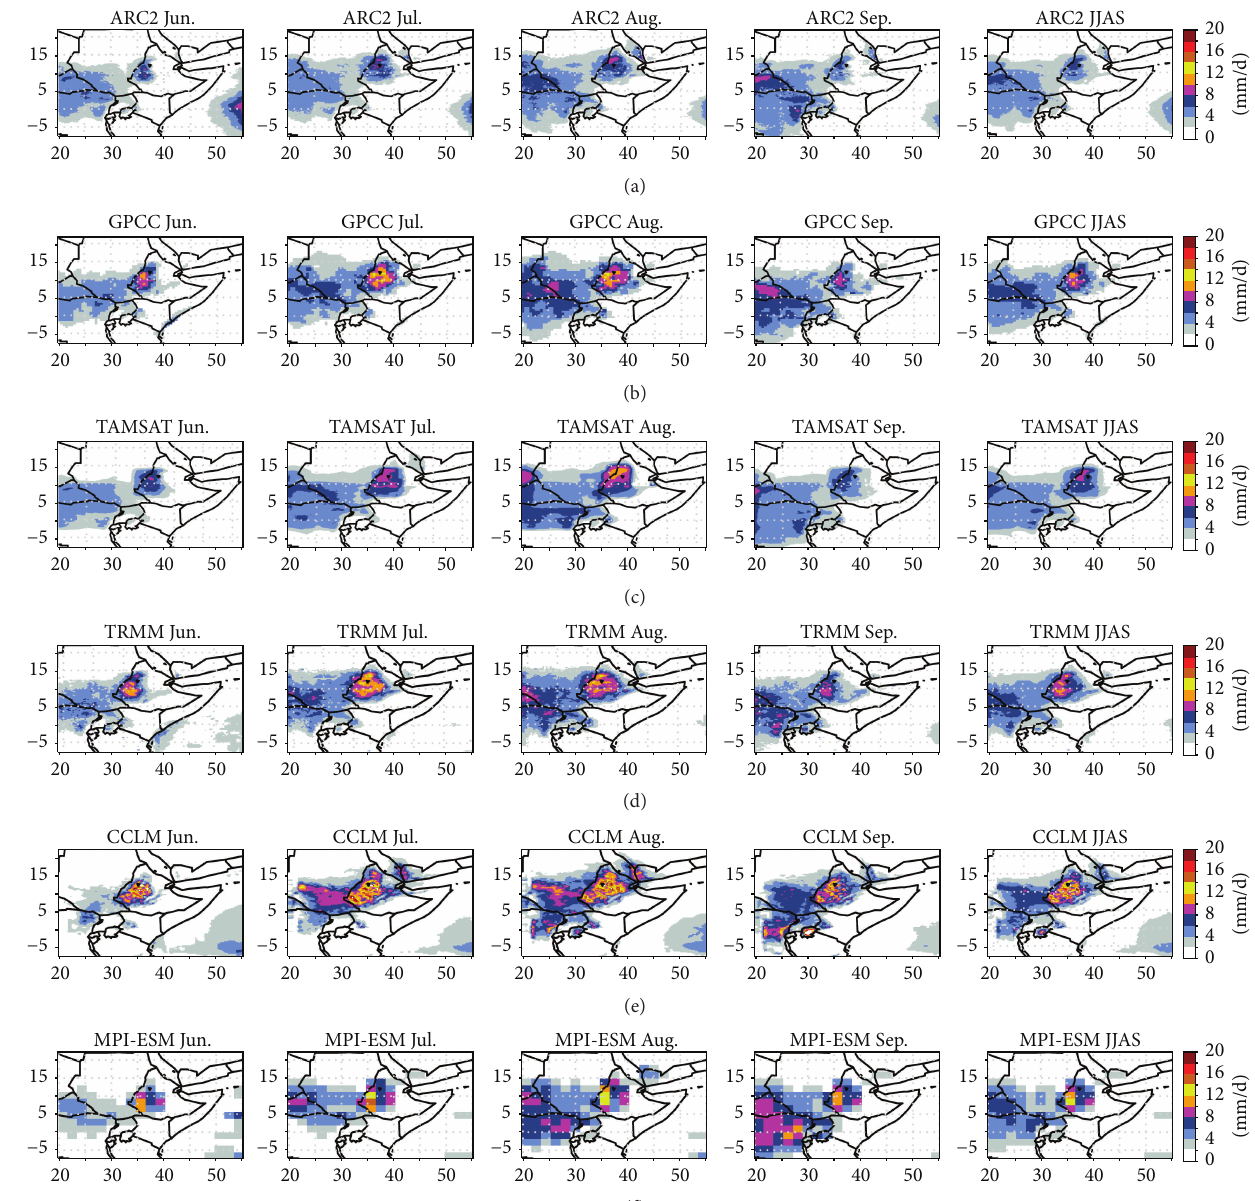
Figure 2: Spatial distribution of mean daily precipitation (mm/d) for ARC2 (first row), GPCC (second row), TAMSAT (third row), TRMM (fourth row), COSMO-CLM (fifth row), and MPI-ESM (last row). Each column represents, respectively, June, July, August, September, and JJAS mean precipitation of